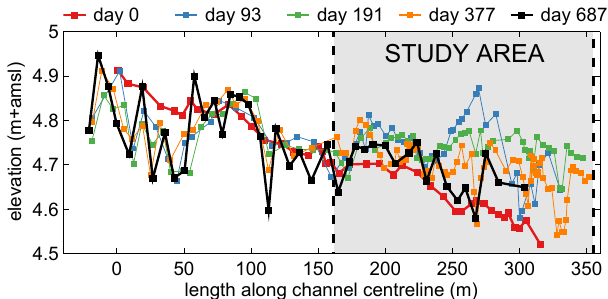
Figure 7. Temporal evolution of the longitudinal bed elevation.